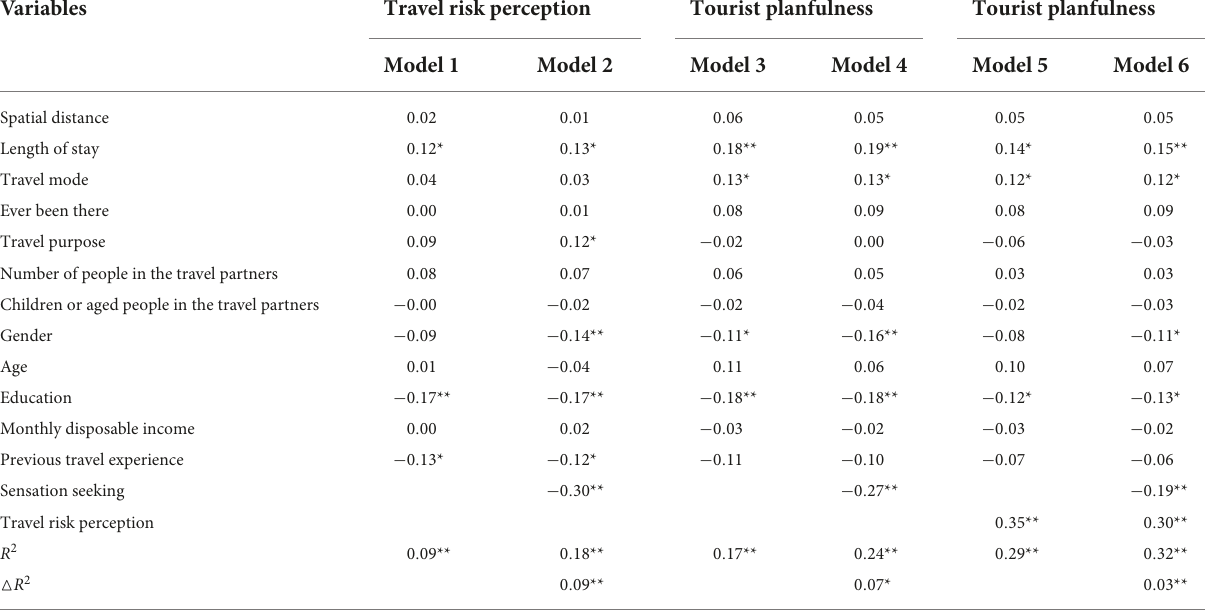
TABLE 2 Regression results for main effect and mediation